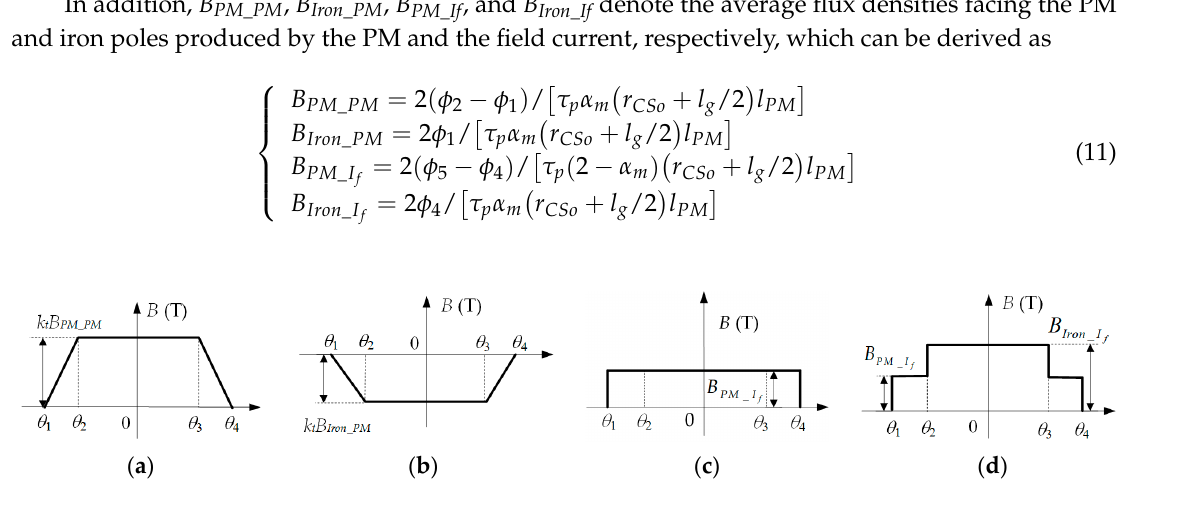
Figure 5. The distributions of eddy currents. ( a ) I f = − 10 A. ( b ) I f = 0 A. ( c ) I f = 10 A.